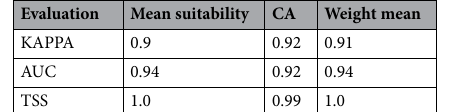
Table 2. evaluation for ensemble models use KAPPA, TSS, and ROC.